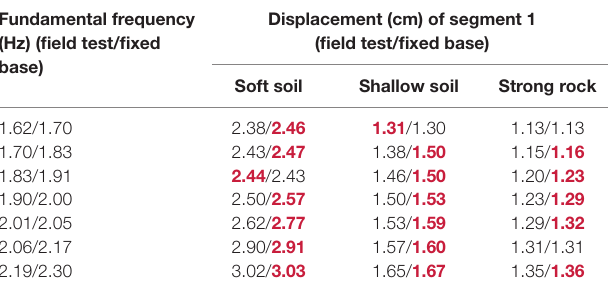
TaBle 5 | comparison of the average maximum absolute displacement of segment 1 with and without ssi.